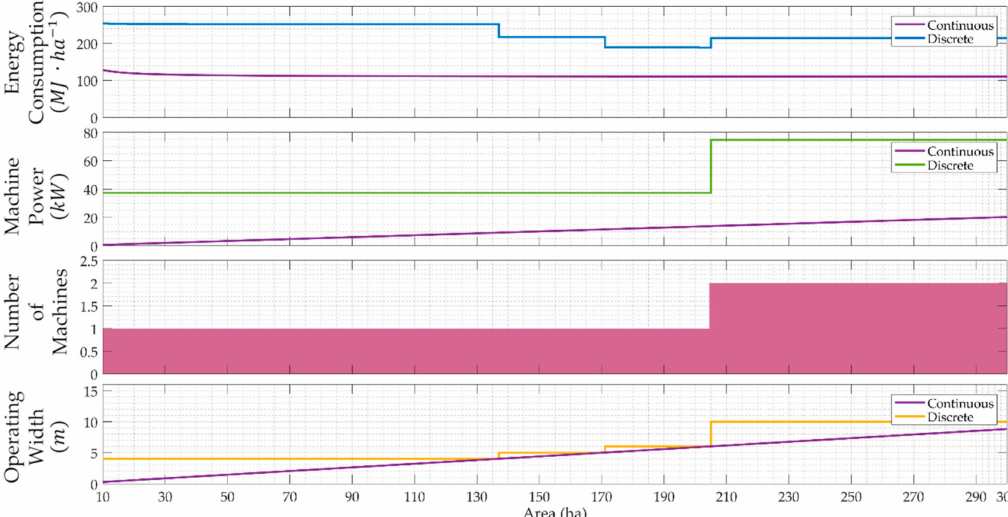
Figure 5. Energy consumption, machine power, number of machines, and operating width for 50 h time available (field